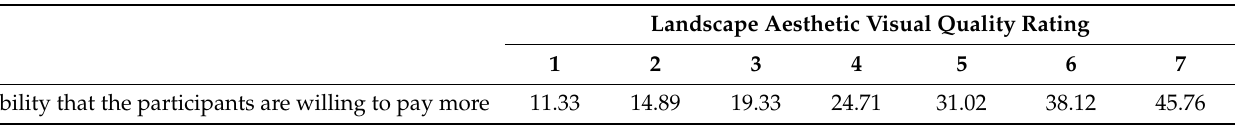
Table 8. Effect of the landscape aesthetic visual quality score on the probability that the participants are willing to pay more for one of the tasted juices (probability expressed in percentage